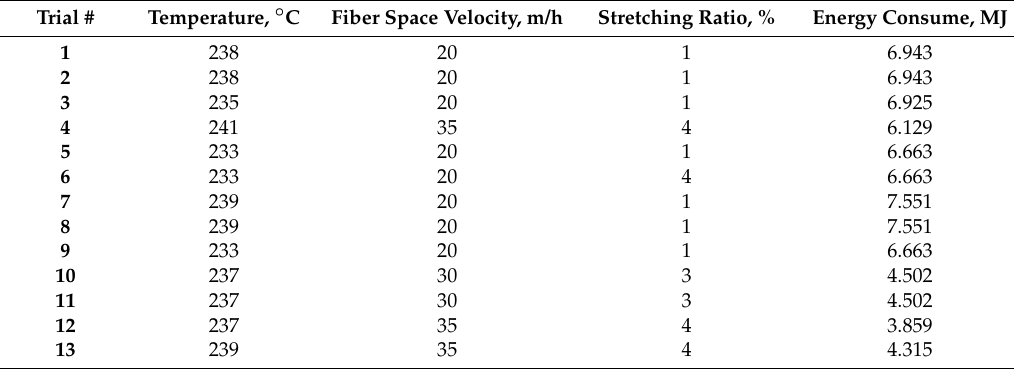
Table 4. Amount of energy consumption for each of the conducted